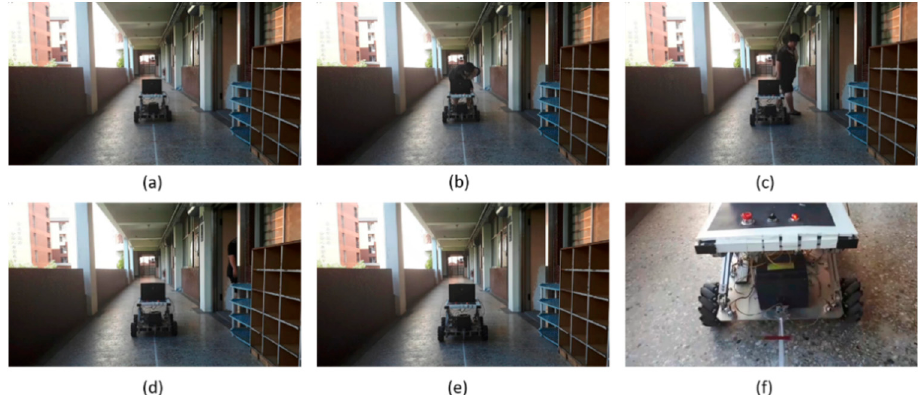
Figure 14. OMWAGV walking straight 100 cm with RLS estimation compensation. ( a ) Starting position, ( b – e ) at middle way, and ( f ) stop position.